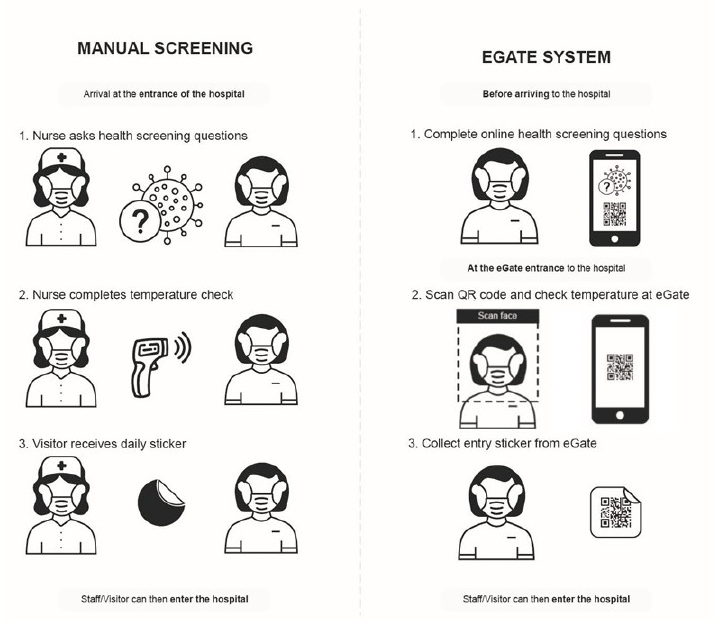
Figure 2. Change in agency from manual to eGate screening. Left : Manual screening methods; Right : eGate digital screening